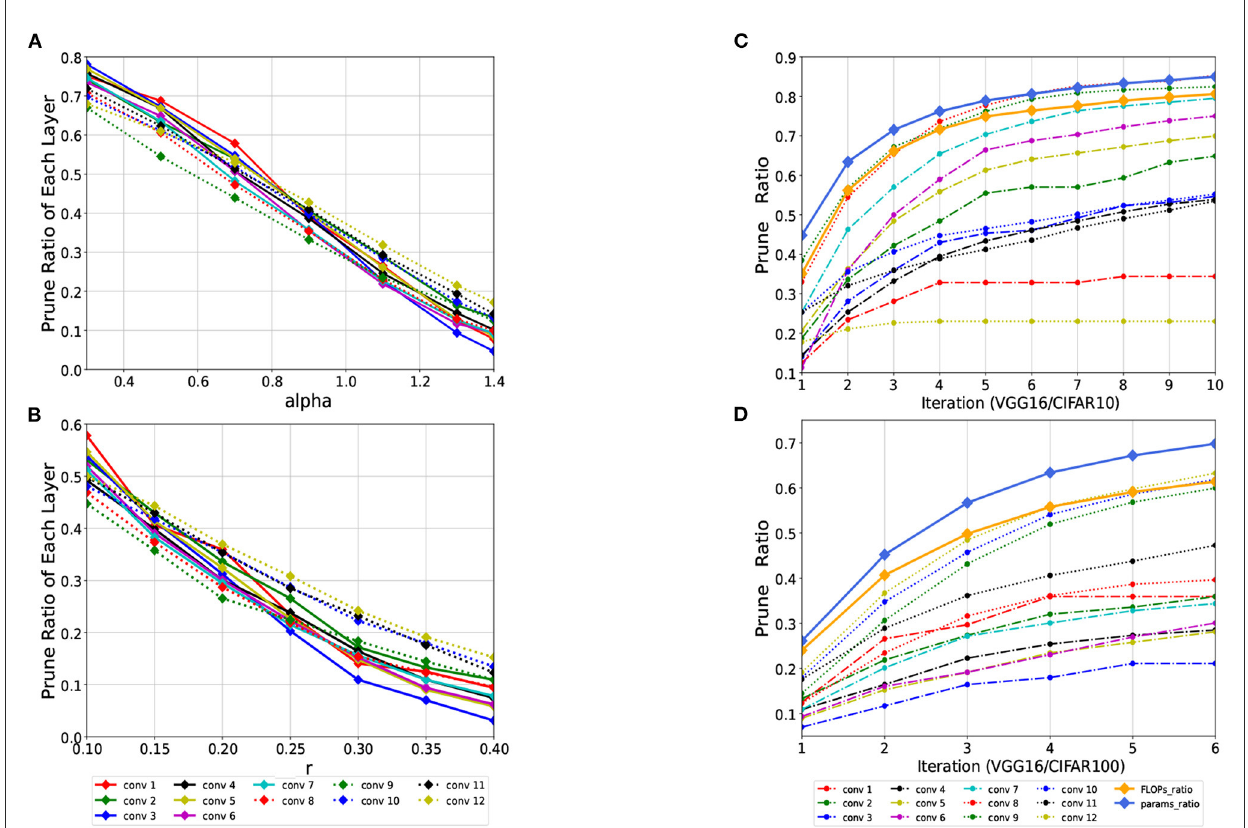
0.35. (B) The pruning rate of =